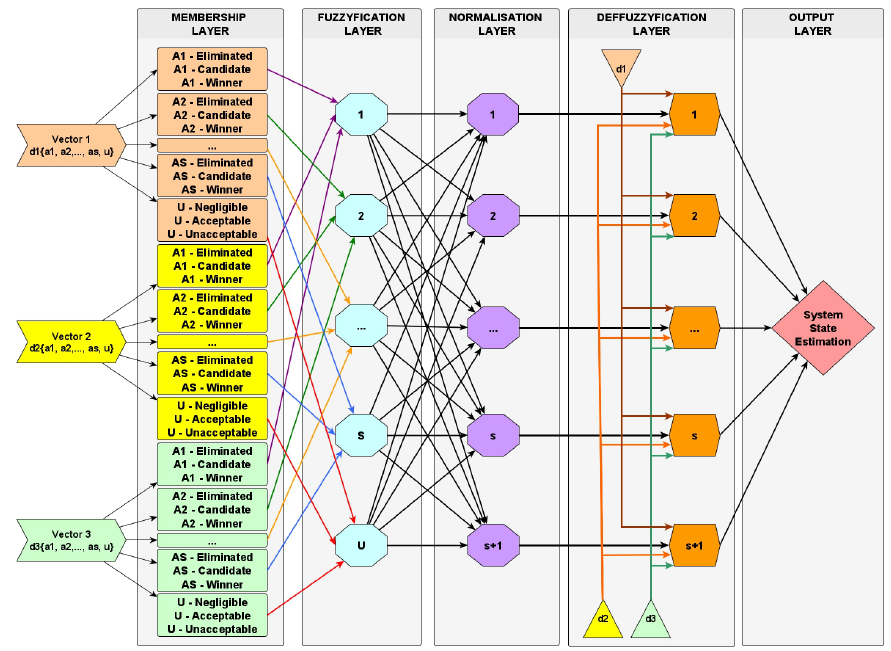
Figure 4. ANFIS applied in this